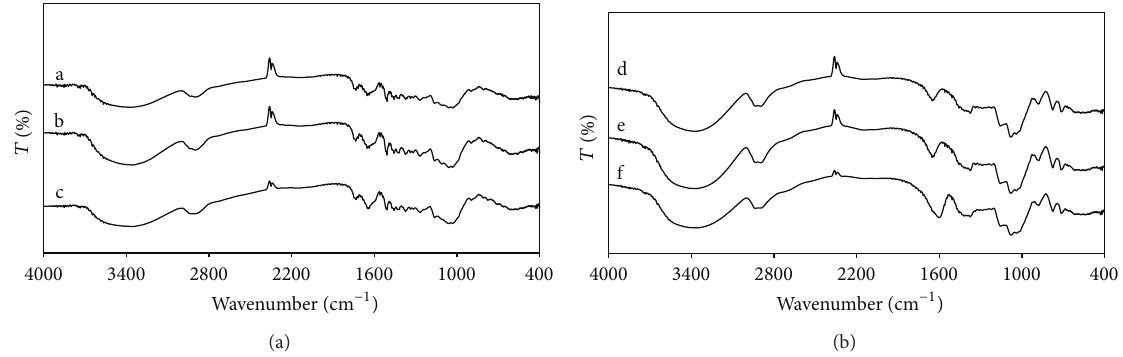
Figure 3: FTIR spectra. (a) samples of L. gmelinii : a—HWE processed. b—UAE processed. c—Unprocessed. (b) Arabinogalactan: d—HWE. e—UAE.